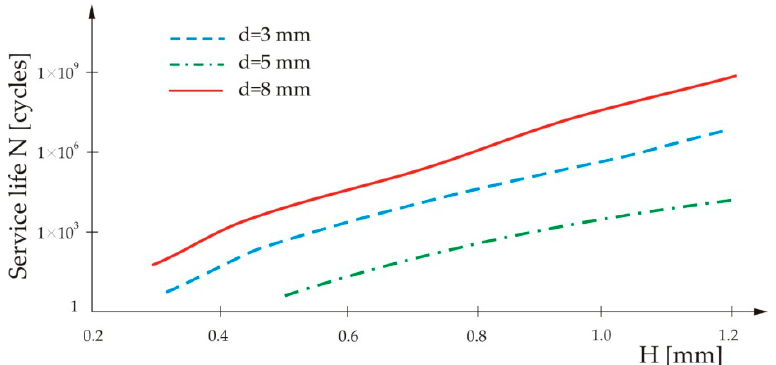
Figure 6. Influence of Thin Sheet 2’s thickness on the service life of the spot-weld for three different nugget diameters.